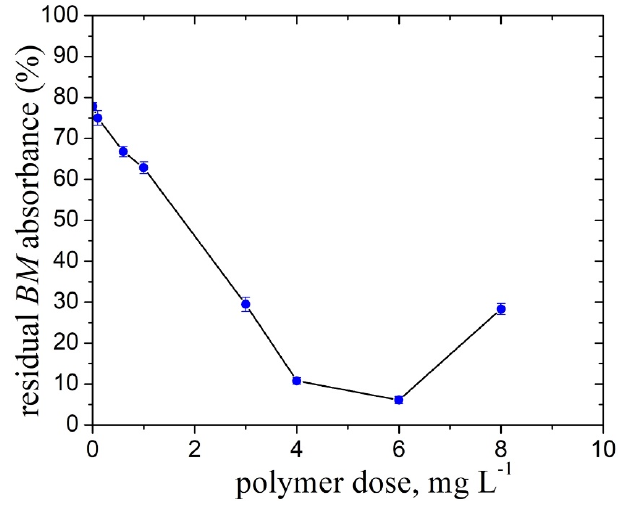
Figure 11. The residual BM absorbance (%) dependence on the polymer dose ( TMAP 0.7 –P ); c ip = 1 g L − 1 ; c BM = 0.5 g L − 1 .